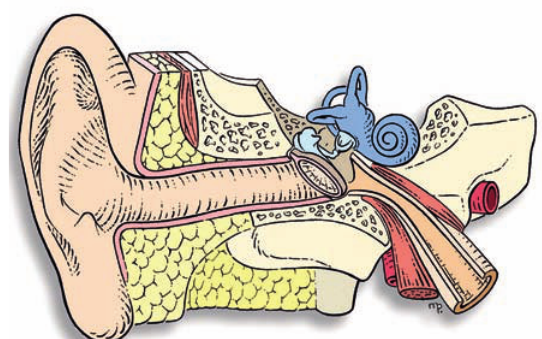
Figure 1 Overview of the ear, cochlea in